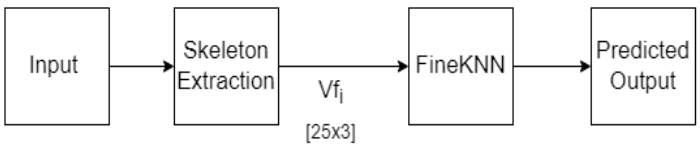
Figure 5. Testing phase of the proposed system.